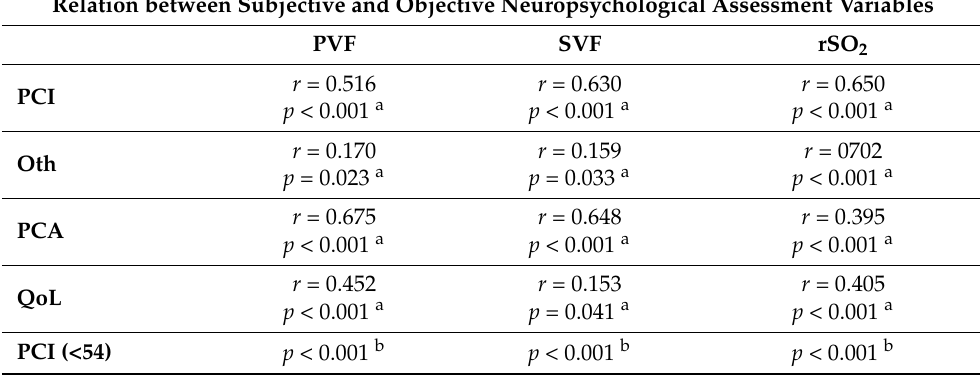
Table 7. Relationship between subjective and objective neuropsychological assessment variables. Relation between Subjective and Objective Neuropsychological Assessment